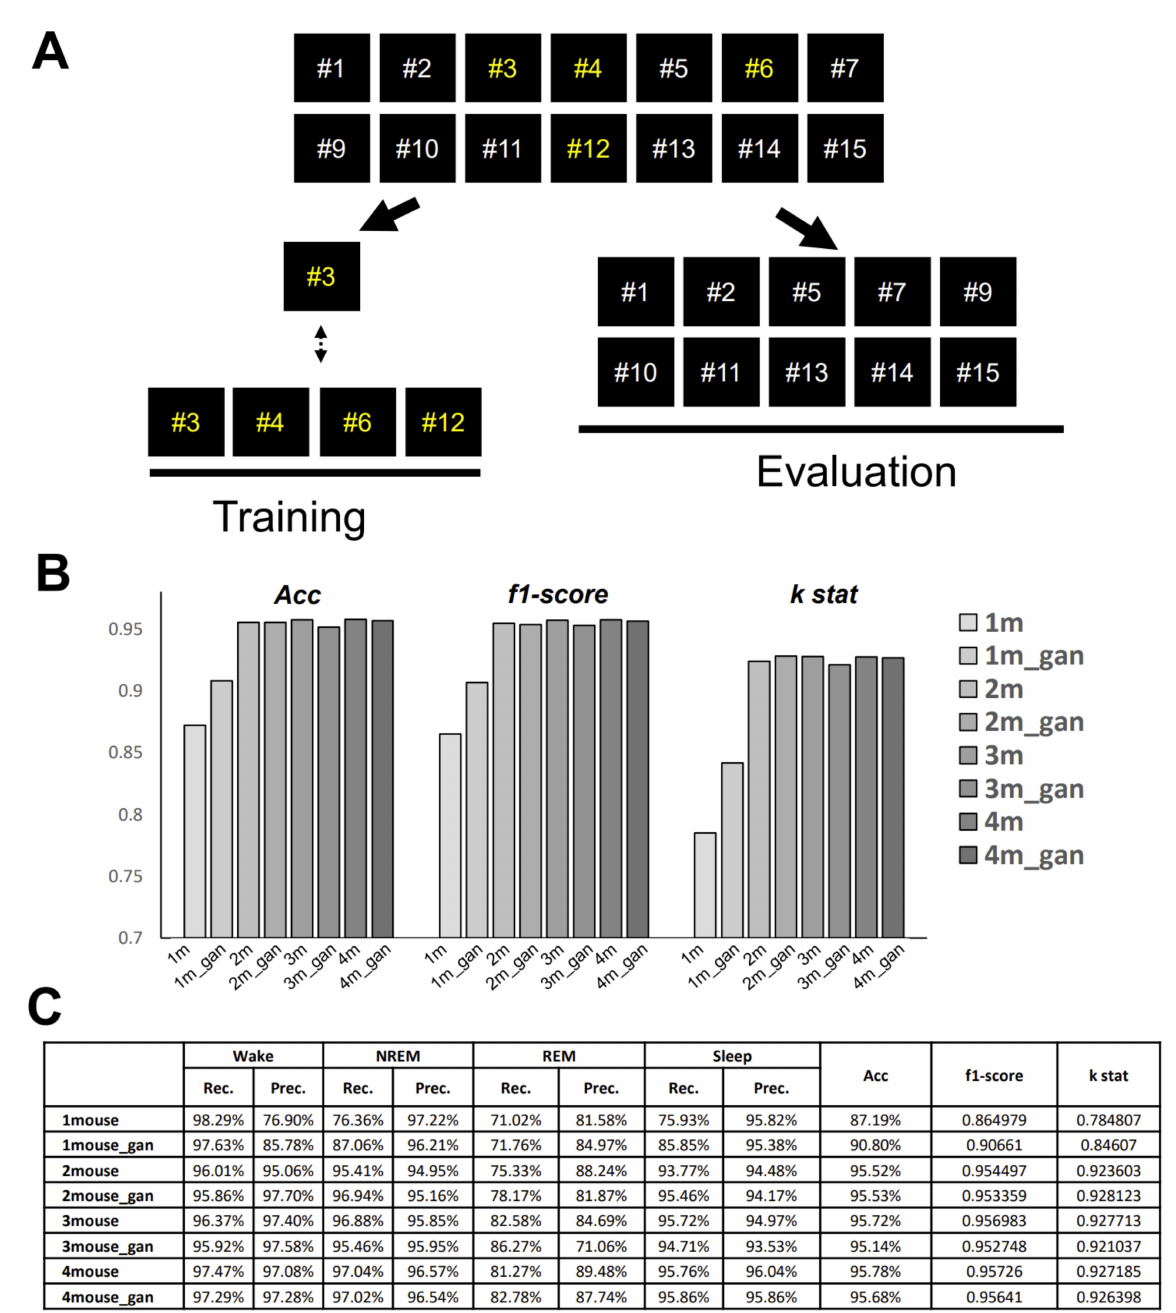
Figure 7. Performance on tiny datasets. ( A ) Schematic of the protocol to test the performance on tiny datasets. The 14-segment dataset was divided into two parts—segments 1 to 4 were used for training, and the remaining 10 segments were used as the evaluation dataset. Yellow font show the specific order number we used for training. ( B ) Comparison bar graph of three parameters under different conditions. ( C ) Data table. Left side show the specific dataset we used for training. ‘_gan’ represents the gan-created data has been added to the dataset for